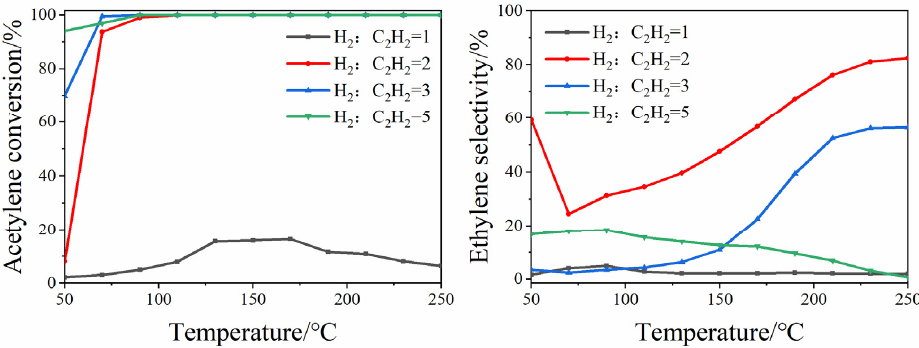
Figure 9. Influence of the hydrogen alkyne ratio on catalytic performance of CuNi 7 /ZSM-12.